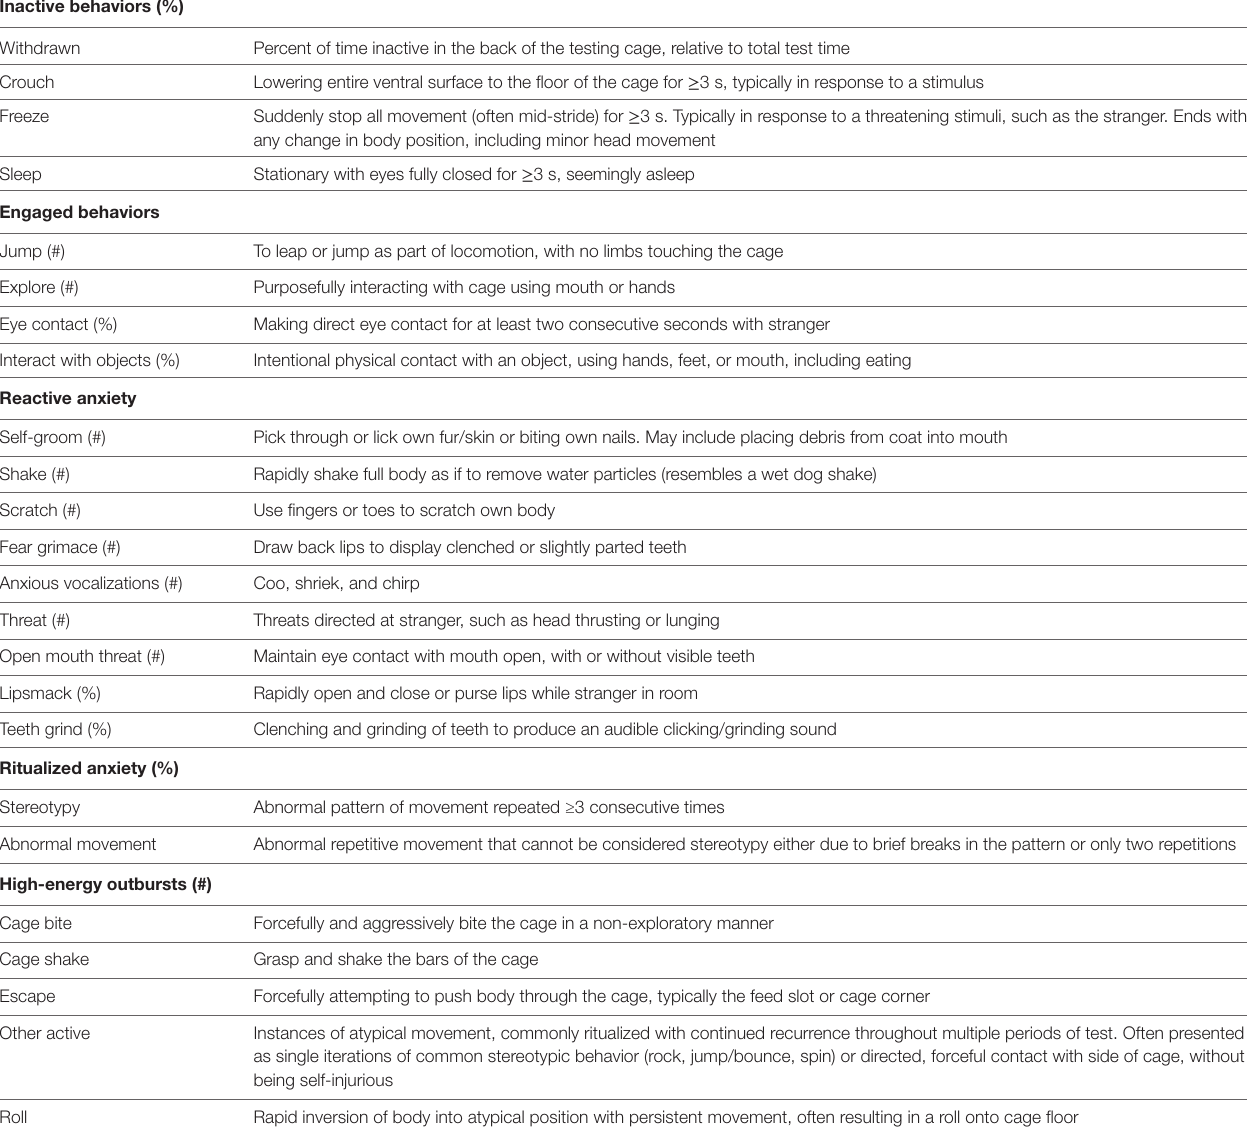
TaBle 3 | Eleven-month temperament assessment